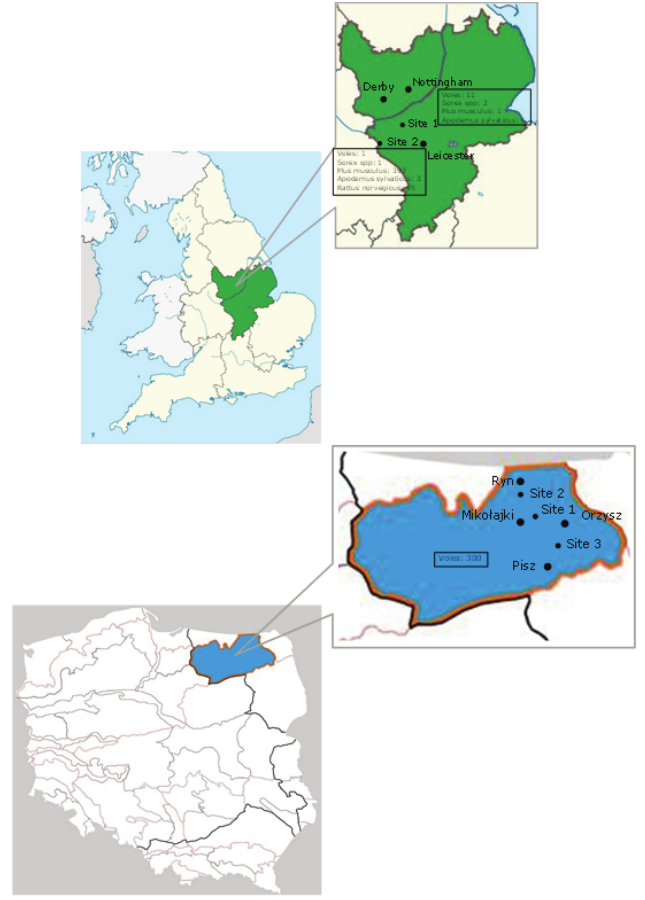
Figure 1. ( A ) Geographical map of the East Midlands region of the United Kingdom. Twenty samples were collected from Site 1 (52°49'13.0" N 1°15'01.9" W), four of which were positive for coronaviruses. Four hundred and ninety three samples were collected from Site 2 (52.6528° N, 1.5297° W), six of which were positive for coronaviruses; ( B ) Geographical map of the Mazury Lake District region of NE Poland. A total of 300 samples were collected from three sites (Site 1: 53°47.7 N 21° 39.6 W, Site 2: 53°53.5 N 21° 32.4 W, Site 3: 53°42.3 N 21° 48.8 W), one of which was positive for coronaviruses.